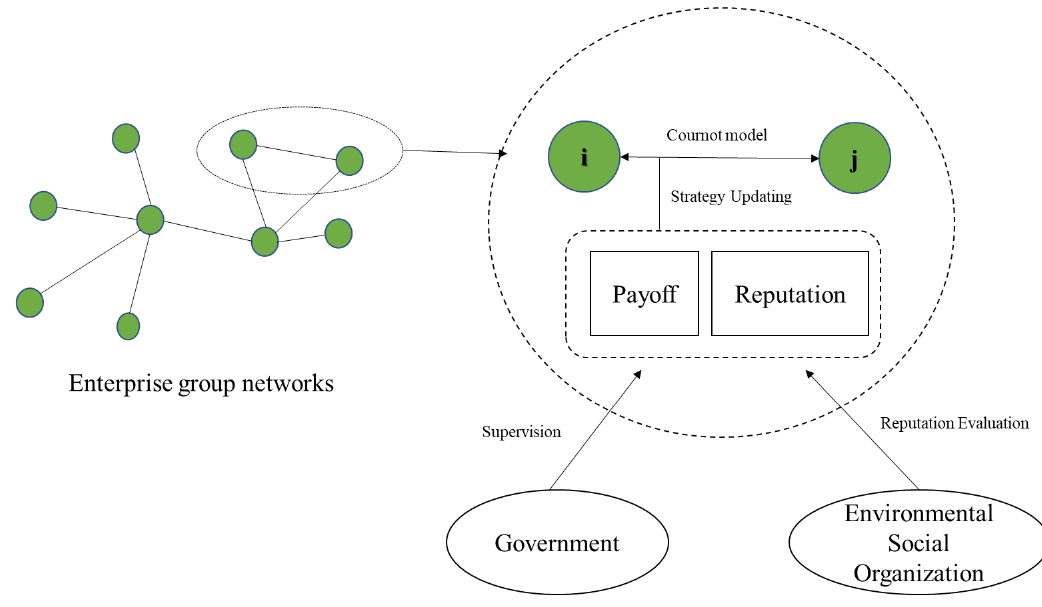
Figure 1. The enterprise group networks and the relationship among agents involved.